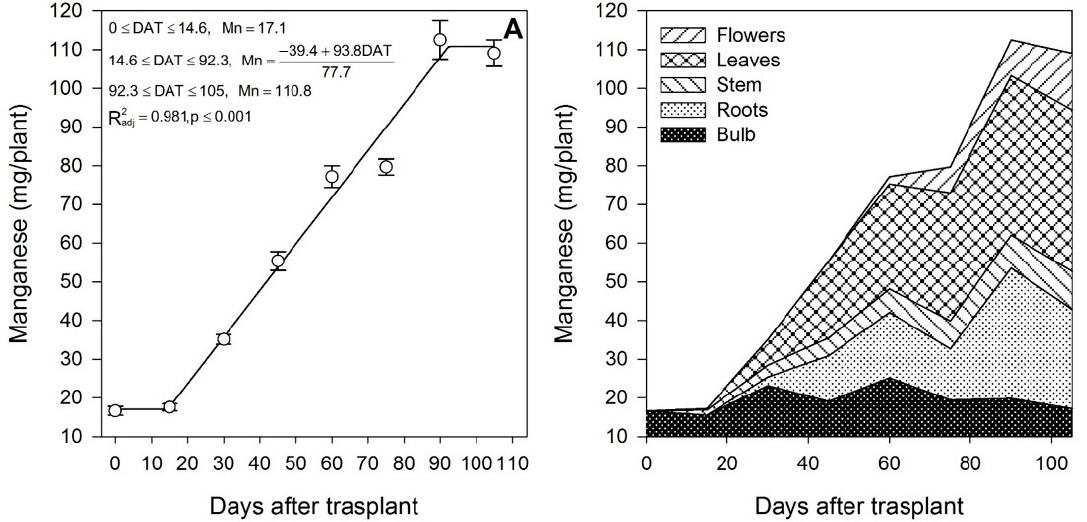
Figure 10. Manganese accumulation in lilium: ( A ) Segmented analysis of manganese accumulation over the growing season; ( B ) Manganese distribution in the lilium plant parts. Day 0 = transplant day, days 0 to 15 = sprouting and initial vegetative growth, days 15 to 60 = rapid vegetative growth plus flower buds formation, days 60 to 105 = blooming. DAT = days after transplant.